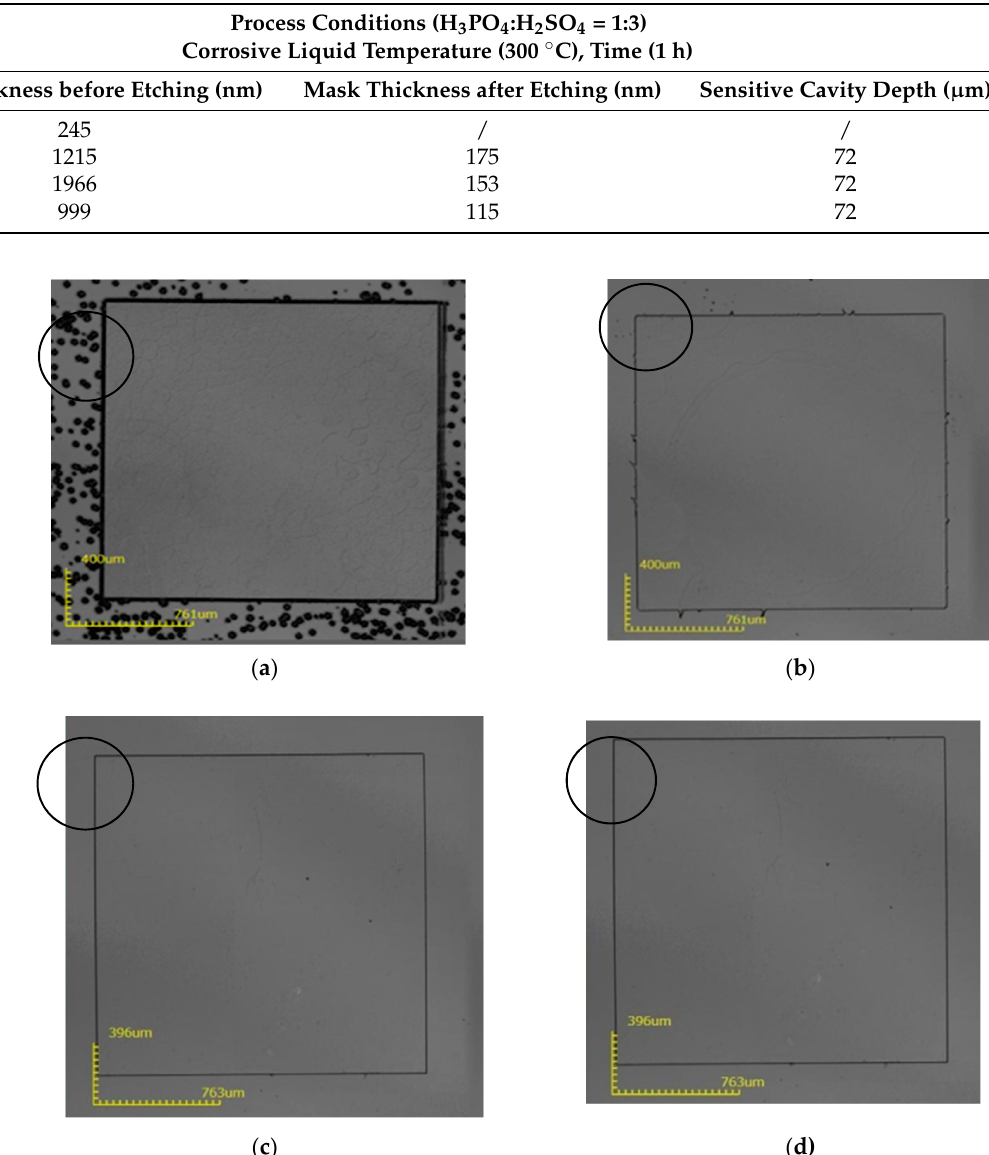
Figure 4. The surface state of the substrate after removing the mask layer after etching at 200